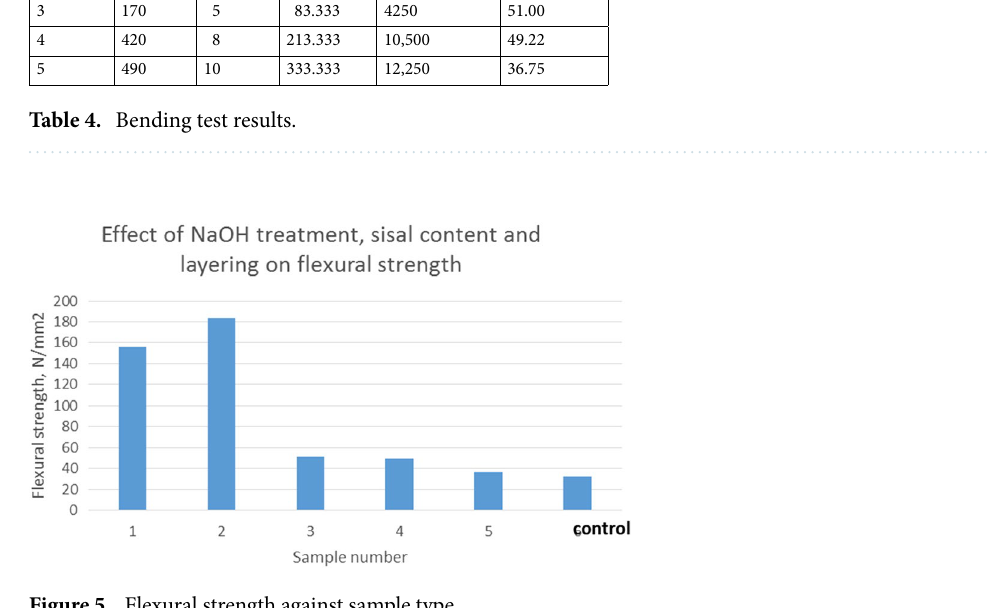
Figure 5. Flexural strength against sample